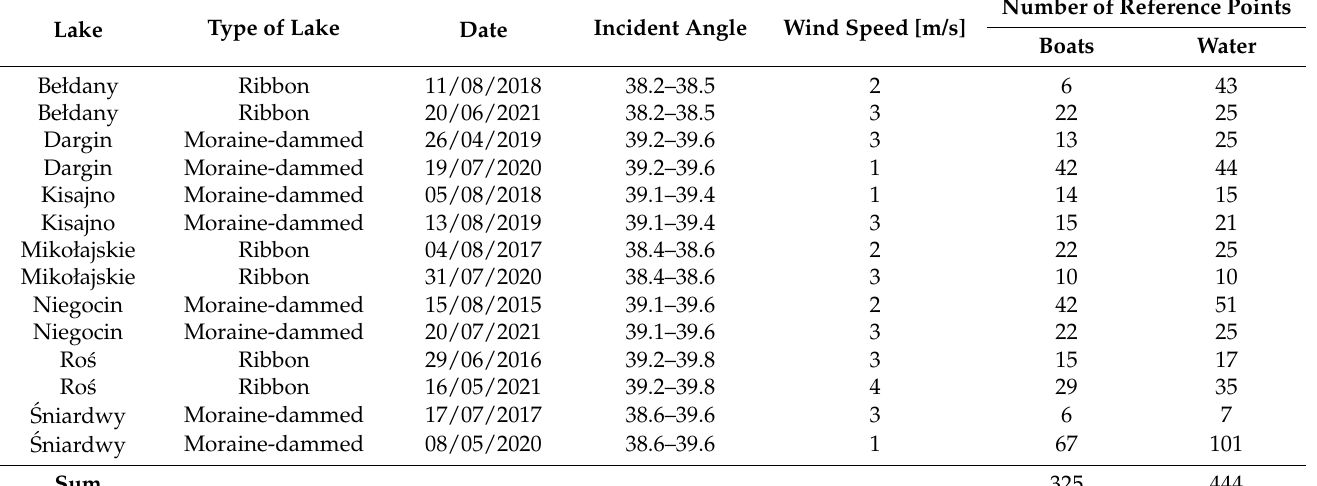
Table 1. Characteristics of the reference datasets.